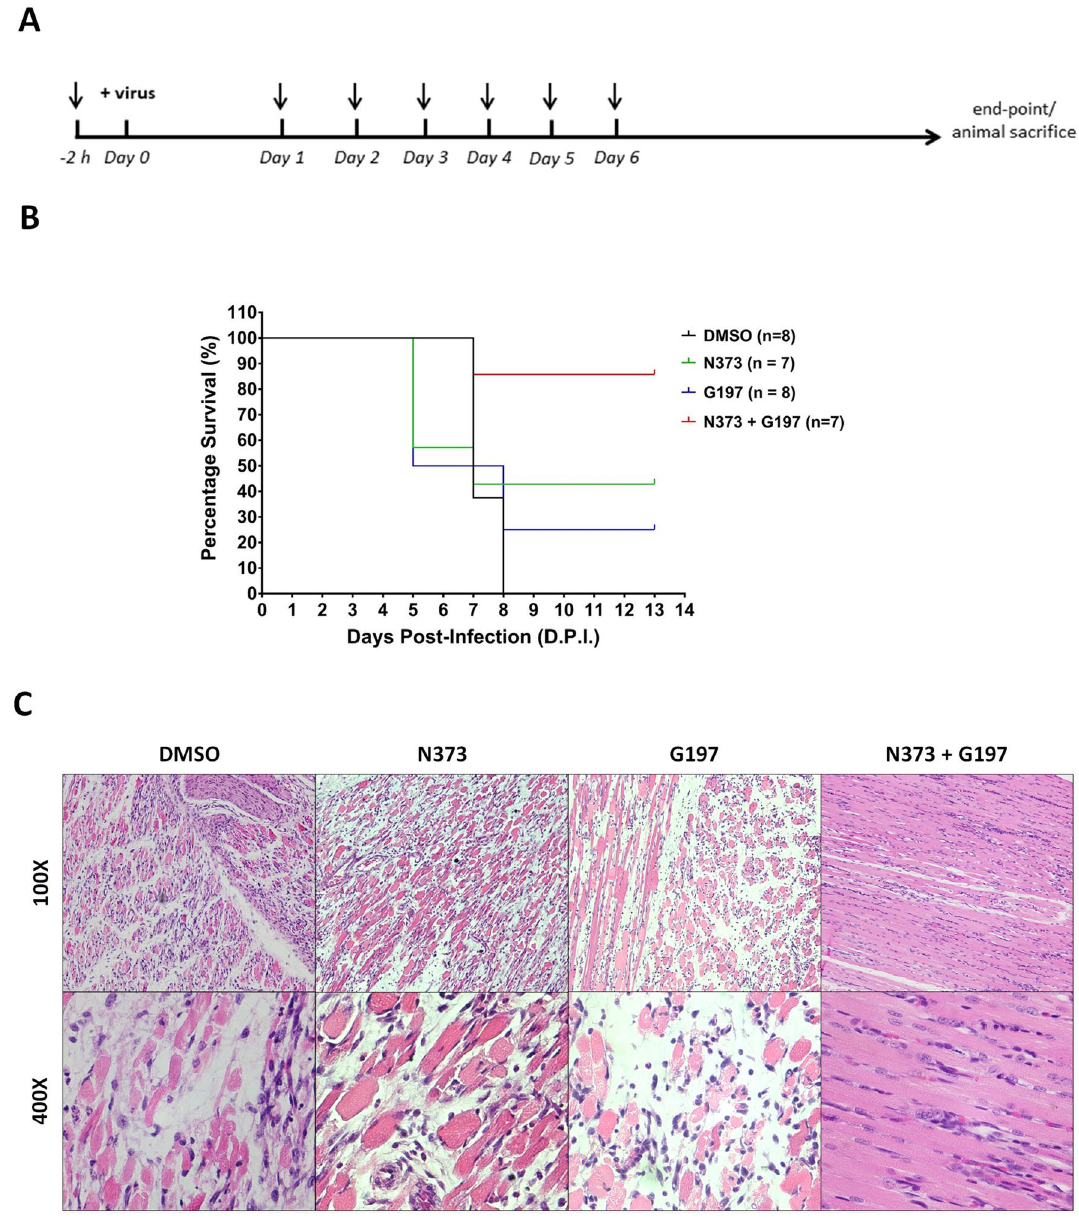
Figure 5. Treatment with both N373 and G197 improved survival and reduced muscle tissue pathology in EV-A71 infected mice. ( A ) Treatment regimen composed of a single dose 2 h prior to infection and 6 daily doses after infection. Animals were observed and sacrificed at 14 days post-infection for survival group and at 5 days post-infection for tissue harvesting group. ( B ) Survival of EV-A71 infected Balb/c neonates showed the greatest improvement when treated with both N373 and G197 followed by N373 only and a slight improvement with only G197 compared to control group (DMSO). ( C ) Haemotoxylin and eosin staining on harvested limb tissue of infected mice at 5 days post-infection showed breakdown of muscle tissue ranging from extensive in control group to negligible in combination treatment group (N373 +